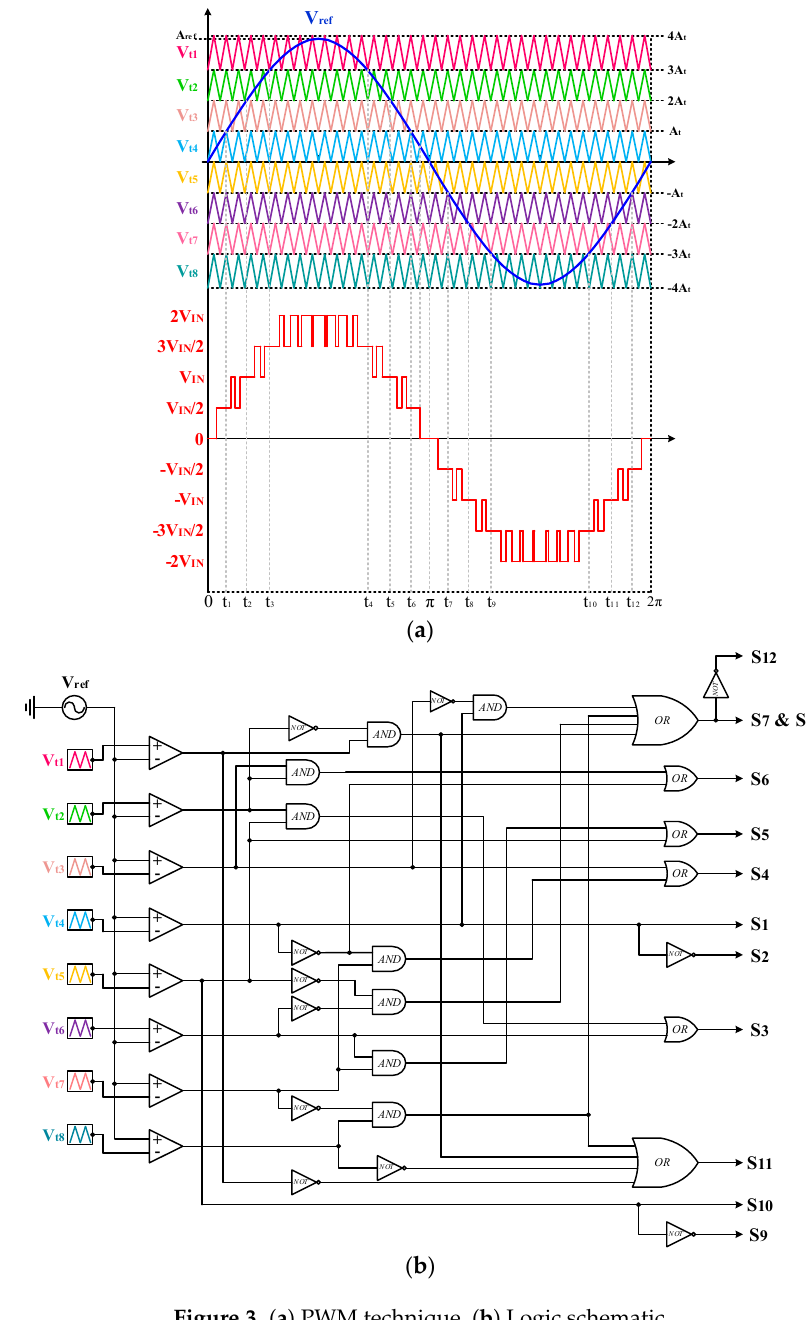
Figure 3. ( a ) PWM technique, ( b ) Logic schematic. Table 3. On-State IGBTs for Each Level.